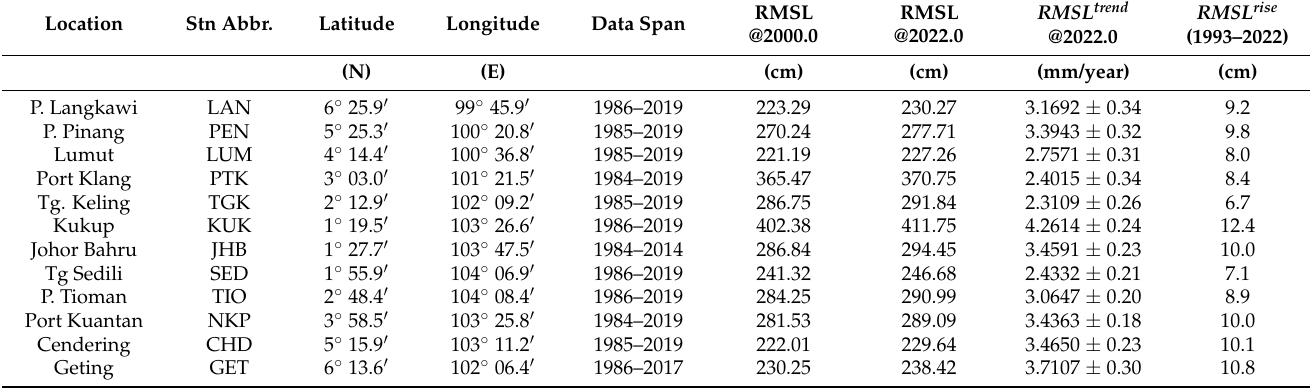
Table 4. Relative mean sea level (RMSL), RMSL trends ( RMSL trend ), and RMSL rise ( RMSL rise ) at the twelve tide gauges along the Peninsular Malaysia